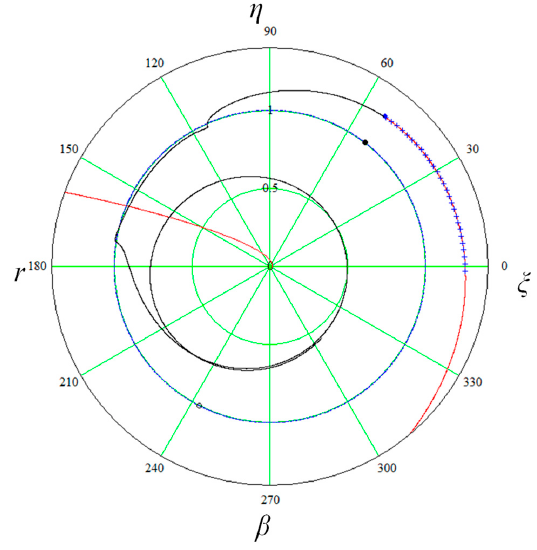
Figure 17. The trajectory of the spacecraft. Enlarged fragment of Figure 16.